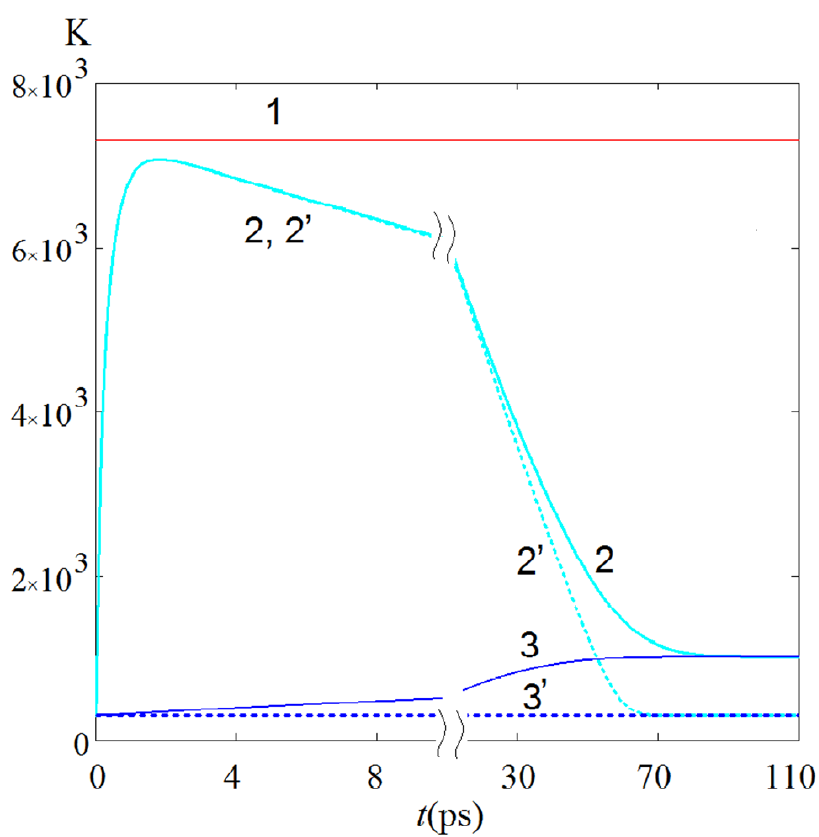
Figure 10. Calculated kinetics of the electron temperature ϑ e (curves 2, 2 (cid:48) ) and crystal lattice temperature ϑ l (curves 3, 3 (cid:48) ) in the region of radiation absorption localization in the tip of the considered GNS under the influence of a rectangular laser pulse of duration t p = 100 fs, power density P S = 250 MW/cm 2 at a resonant wavelength of 665 nm. The solid (dashed) curves correspond to the adiabatic (isothermal) boundary condition at the initial condition N ( t = 0) = 0, ϑ e ( t = 0 ) = ϑ l ( t = 0 ) = 300 K; the solid red level (marked with the number 1) is the temperature of the Coulomb explosion. The results were obtained with parameters: τ ee = 410 fs, γ = 68 J m − 3 K − 2 , G = 0.91 × 10 16 W m − 3 K − 1 , C l = 2.5 × 10 6 J m − 3 K − 1 .